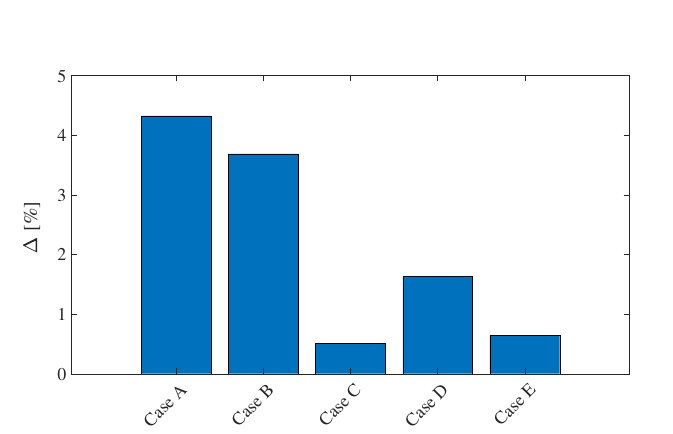
Figure 2: Output data dependencies of the probability of error of different (cid:15) -PIP architec- tures. Case A: parallel architecture. Case B: serial architecture with minimum sized gates. Case C: parallel architecture with jitter. Case D: serial architecture with minimum sized gates and power gating. Case E: serial architecture with bigger gates and power